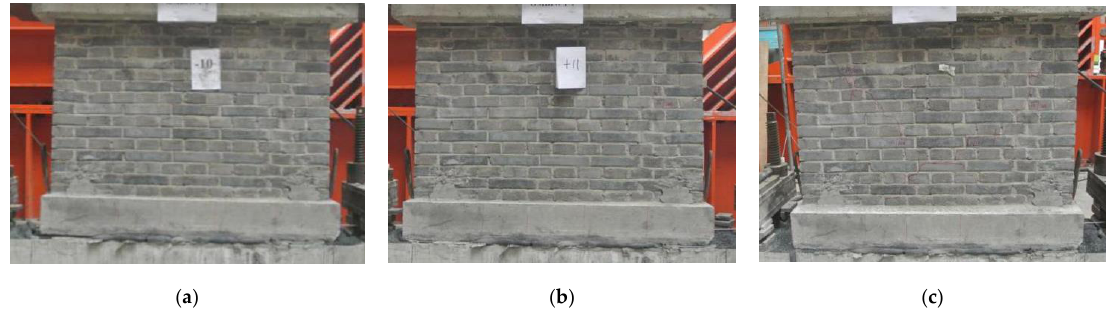
Figure 11. Failure process of GGBW-2: ( a ) slide isolator; ( b ) preliminary cracking; ( c ) specimen failure.